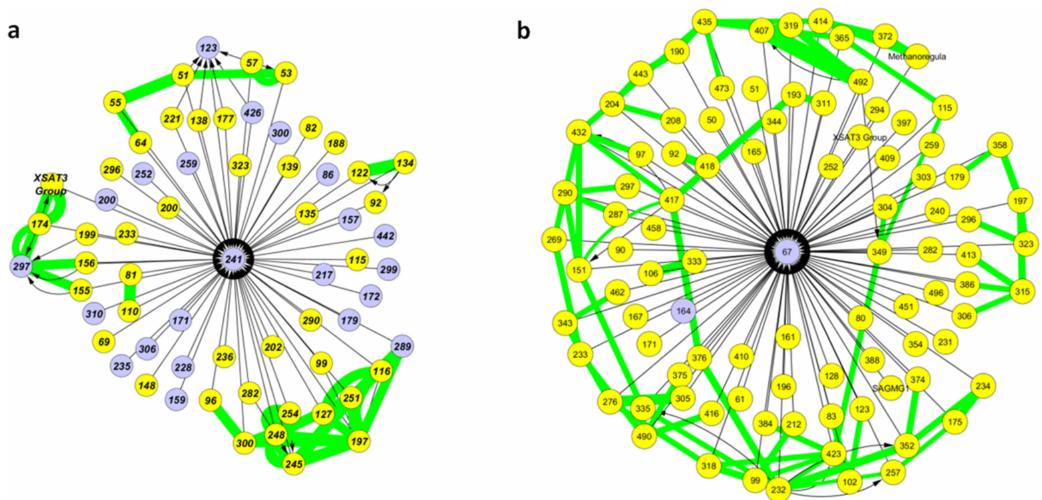
Figure 4. Selected representative hub nodes of the association rule networks only participating as rule targets. Showing all rule associations involving the central hub node fragment and directly neighboring fragments (arrows), and overlaying the co-occurrence network with green edges indicating co-occurrence relationships. Bacterial fragments are shown in light blue and archaeal fragments in yellow. Networks are based on Rsa I digestion. ( a ) The top fourth hub node of the bulk data set; ( b ) The top fourth hub node of the single particle data set